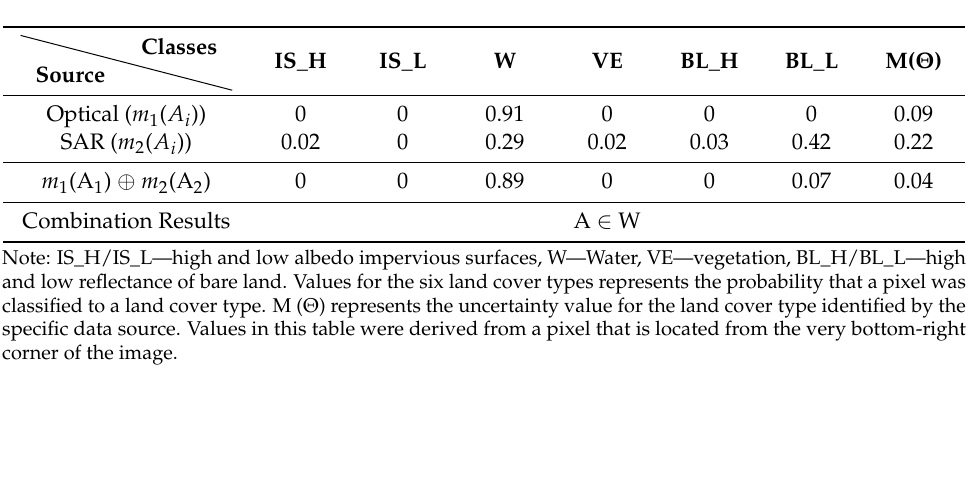
Table 2. The mass function values of the six classes and the combination results.